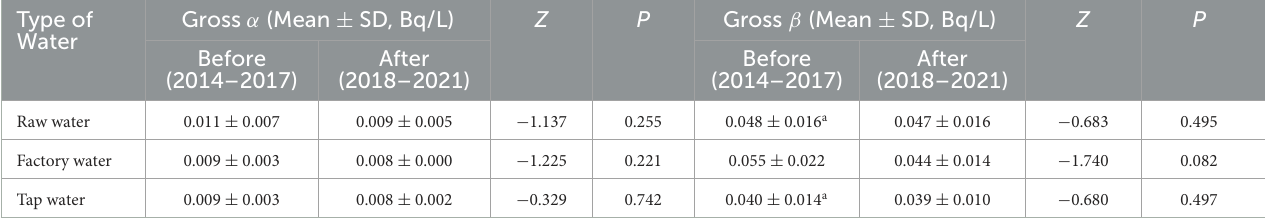
TABLE 5 Statistical test for drinking water radioactivity comparison before and after the operation of SNPP.